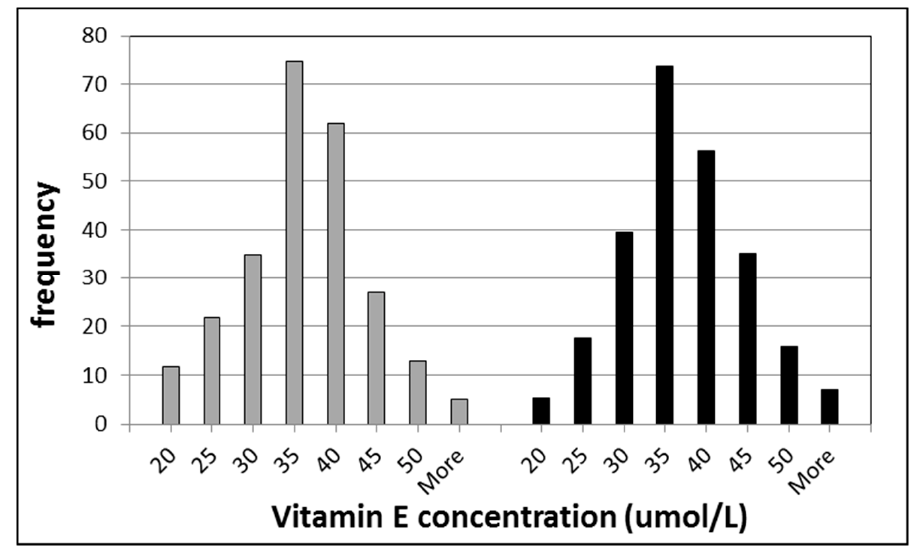
Figure 2. Histograms of vitamin E (the sum of α - and γ -tocopherol) concentrations in healthy individuals. The left part represents the data for men and the right part for women.